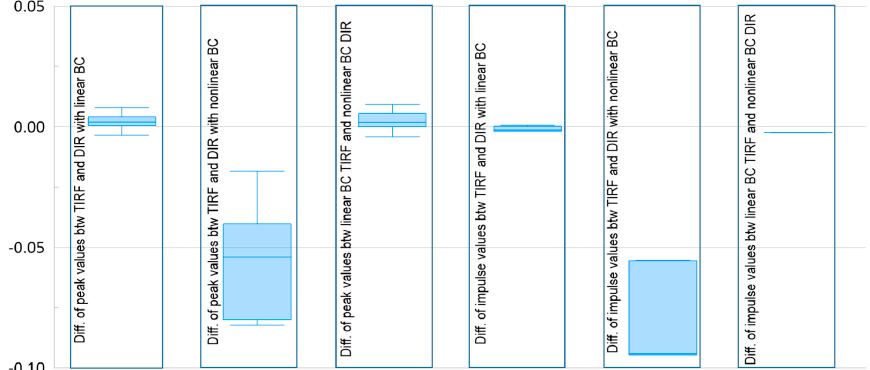
Figure 10. Box and whisker plots for the difference in the peak shear stresses and impulse values